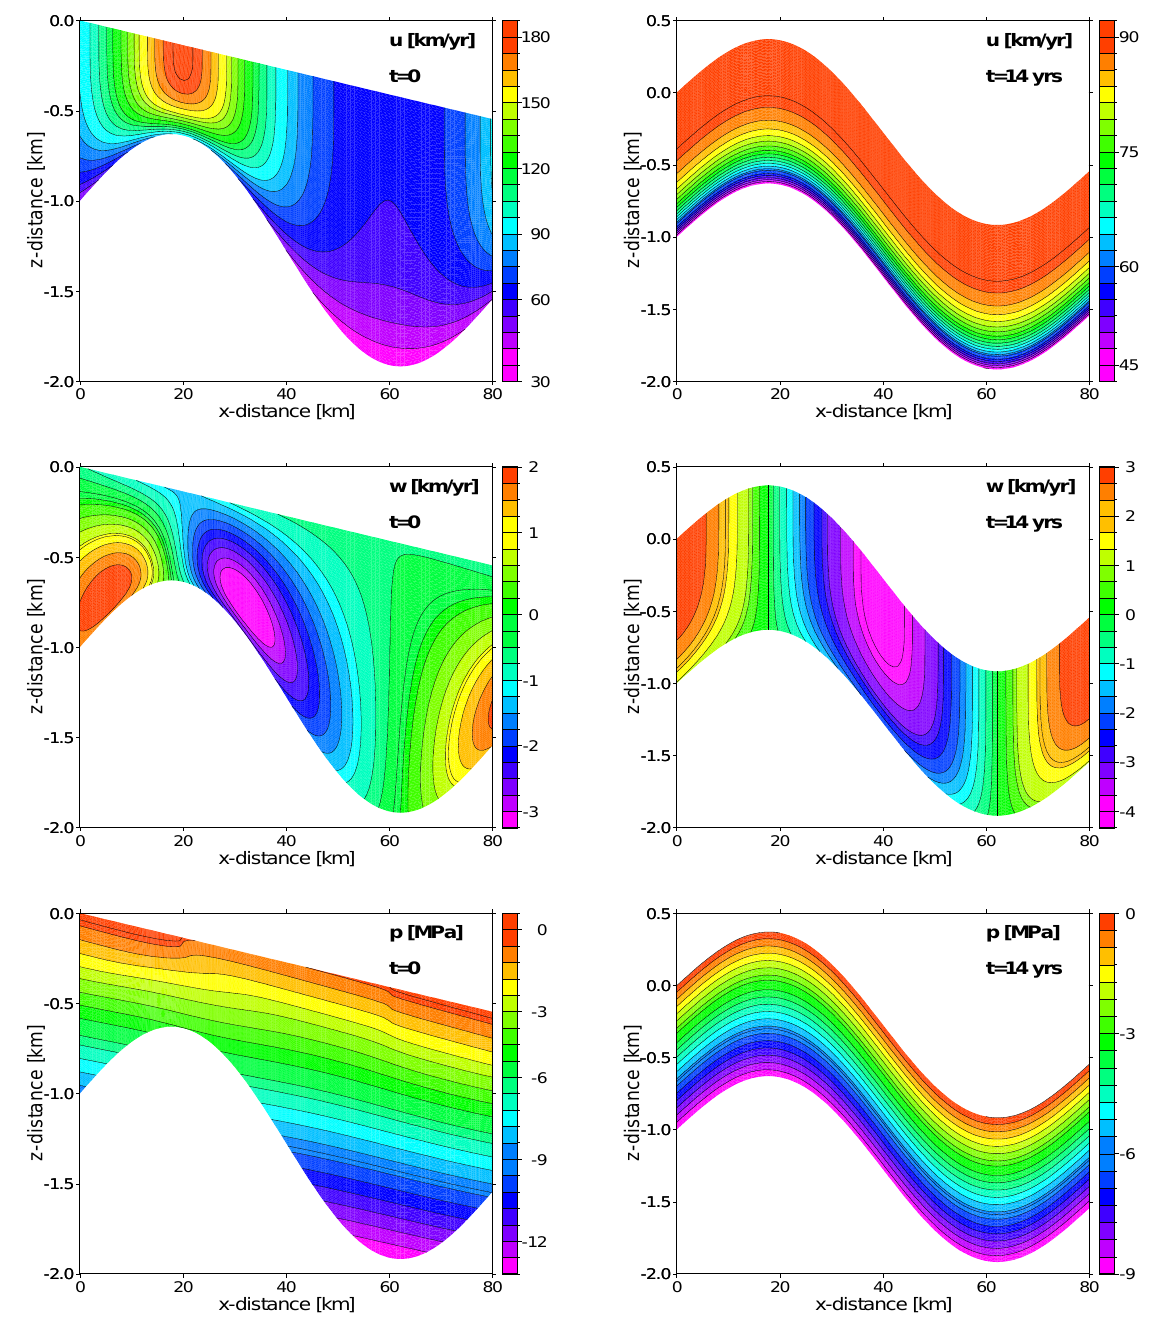
Fig. 3. 2-D flowline time dependent experiment – ice stream flow over bumpy bed. The graphs show the horizontal velocity u , the vertical velocity w (both in km/yr), and the ice pressure p (in kPa) at the beginning (left) and at the time when the steady-state solution is reached (right). At the beginning, the horizontal velocity is anti-correlated with ice thickness: it is larger over the bump than over the trough. At the steady-state, the horizontal velocity is spatially uniform and increases from the bed to the surface with power of λ = 4 of the ice thickness. At the beginning, the vertical velocity is largest at the bed where ice shearing is the largest. At the steady-state, the vertical velocity is almost uniform in every vertical slide. This is consistent with ice-stream flow. The ice pressure is proportional to the ice thickness. At the steady-state, it is equal zero at the ice